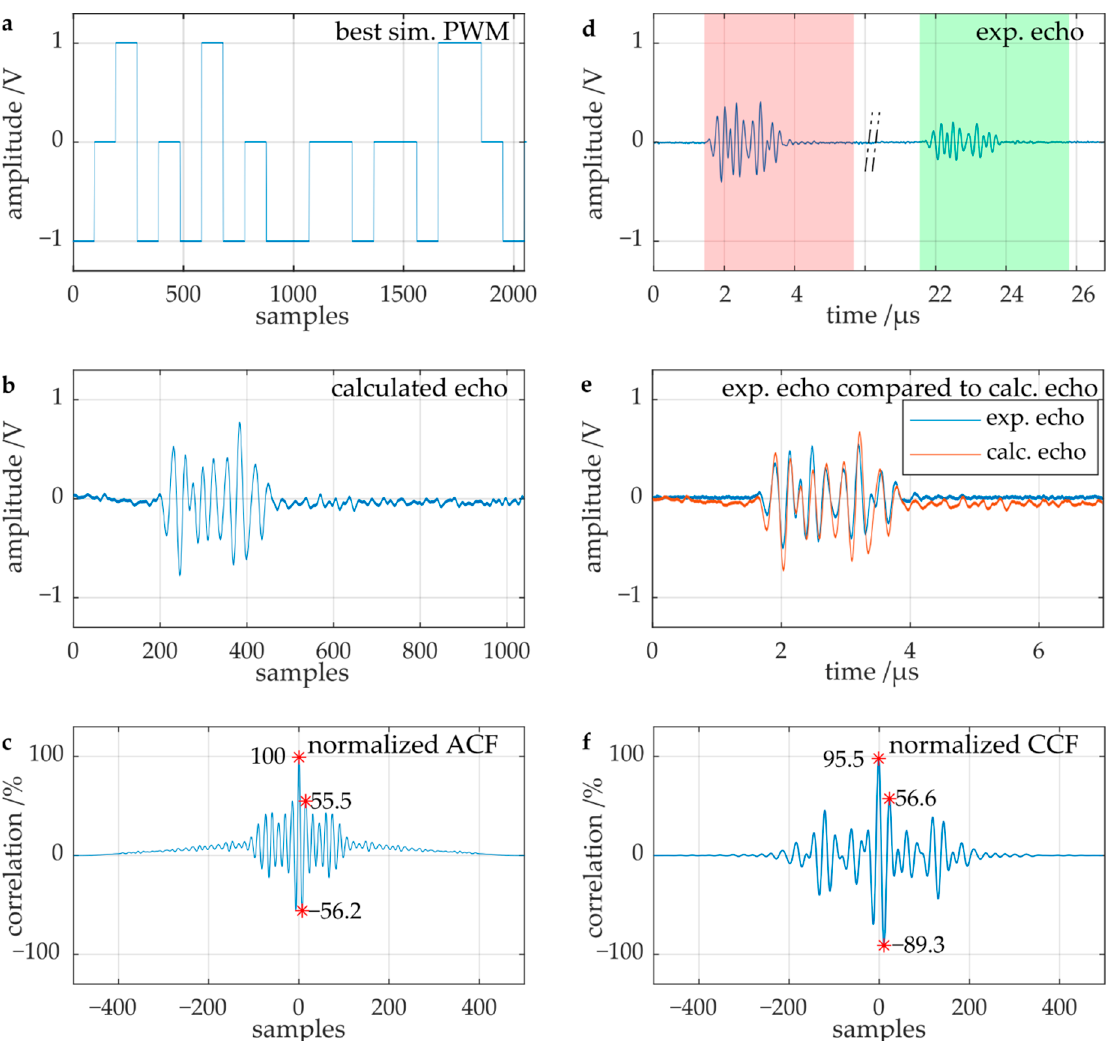
Figure 4. Automatically optimized sequence from the simulation and comparison to the experimental results: ( a ) best PWM sequence generated by simulation, ( b ) calculated echo, ( c ) normalized ACF, ( d ) experimental ultrasonic echo, ( e ) comparison between the calculated echo and the experimental echo, ( f ) normalized CCF. The * markers highlight the extrema of the CCF and ACF.